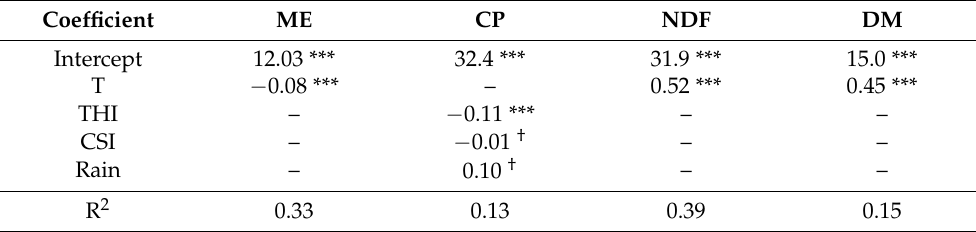
Table A1. Regression coefficients of climate variables explaining herbage nutritive value